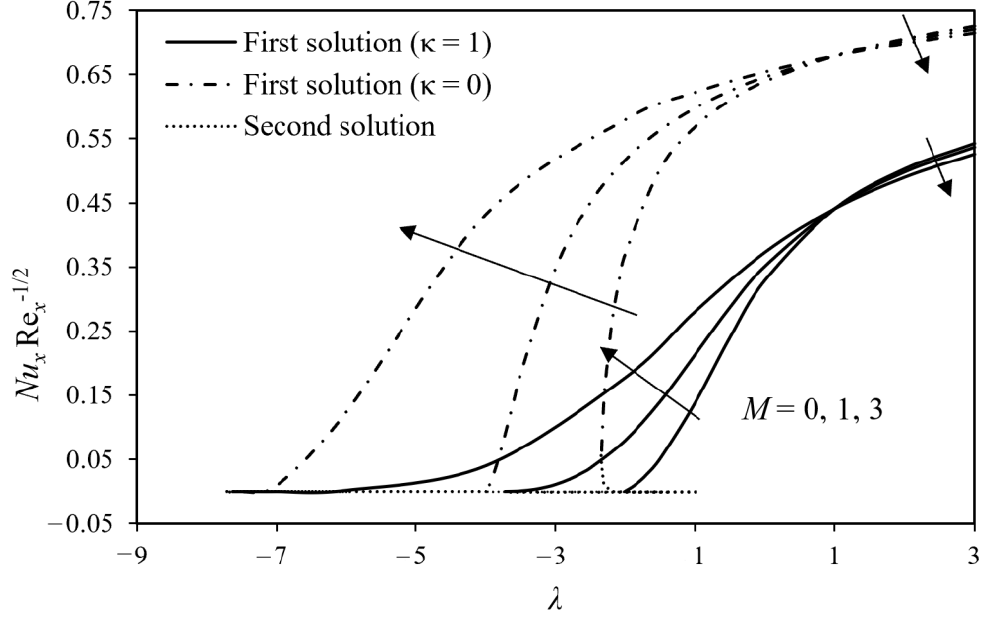
Figure 6. The variations of Nu x Re − 1/2 x with the stretching/shrinking parameter, λ , for different M and κ when φ = 0.01, A = 1, and δ T = 1.